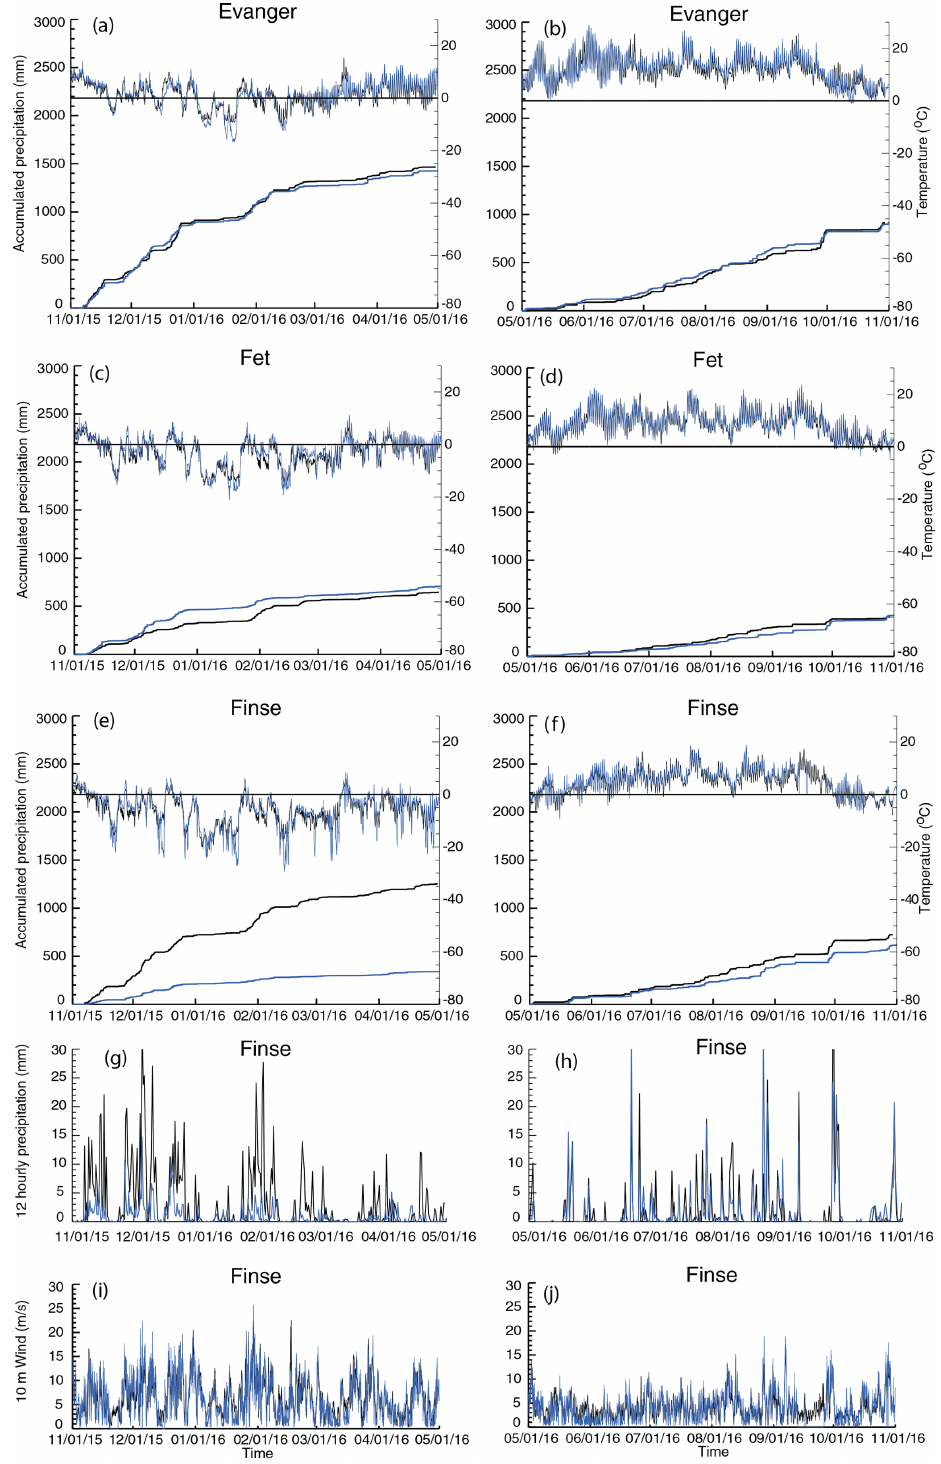
Figure 5. Observed (blue) and modeled (black) accumulated precipitation and temperature at Evanger (a, b) , Fet (c, d) and Finse (e, f) stations for the 2016 winter season (a, c, e, g, i) and 2016 summer season (b, d, f, h, j) . Panels (g) and (h) show the time series of precipitation. The bottom panels (i, j) show the 10m wind speed at